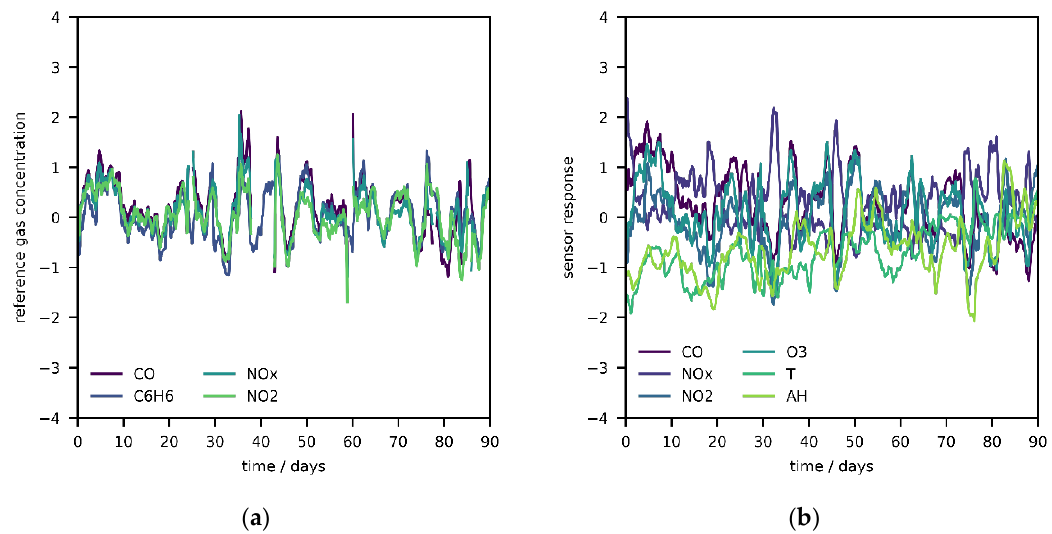
Figure 4. ( a ) Time series section of standardized reference signals smoothed with moving average of 24 h windows; ( b ) standardized sensor signals smoothed with moving average of 24 h windows.